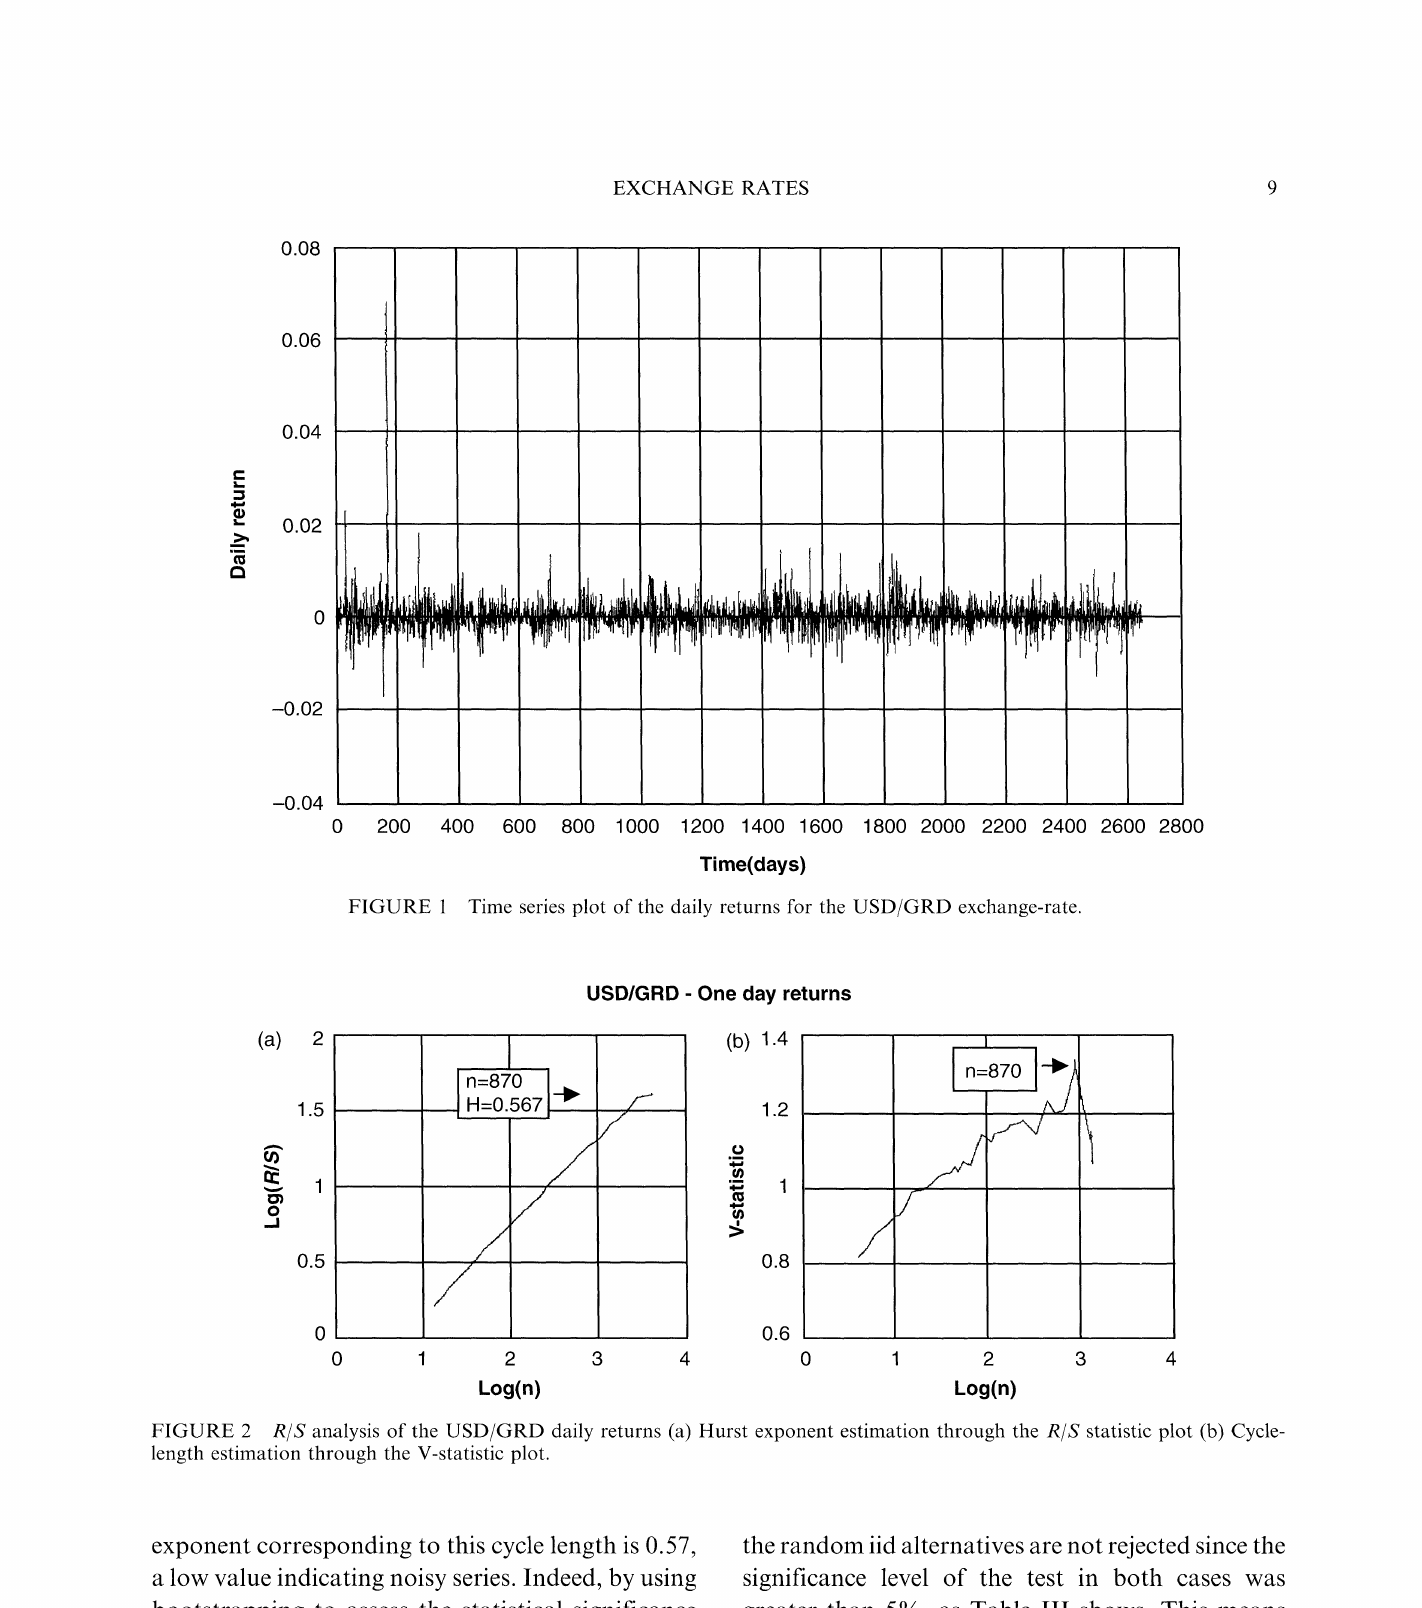
exponent corresponding to this cycle length is